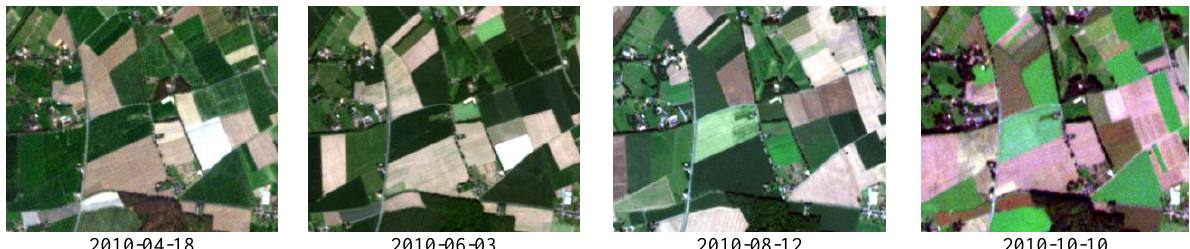
Figure 1. RapidEye images 2010 (© 2010 RapidEye AG, Germany. All rights